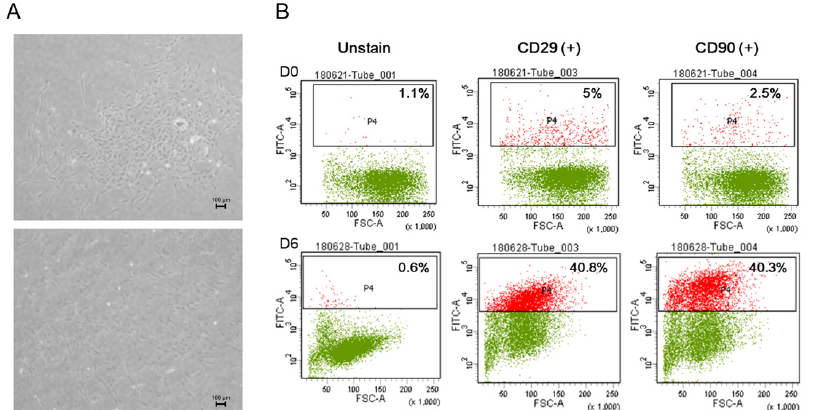
Figure 2. In vitro characterization of uncultured stromal vascular fraction cells isolated from rat adipose tissue. ( A ) Phase-contrast image on day 5, passage 0 and day 1, passage 1. ( B ) Cell surface markers CD29 and CD 90 showed the stemness of the rat stromal vascular fraction cells from day 0, with outstanding results by day 6. This indicates the high potential of rSVFs as an efficient source bone differentiation. Scale bar: 100 µ m, magnification: × 100. for bone differentiation. Scale bar: 100 µm, magnification: ×100.